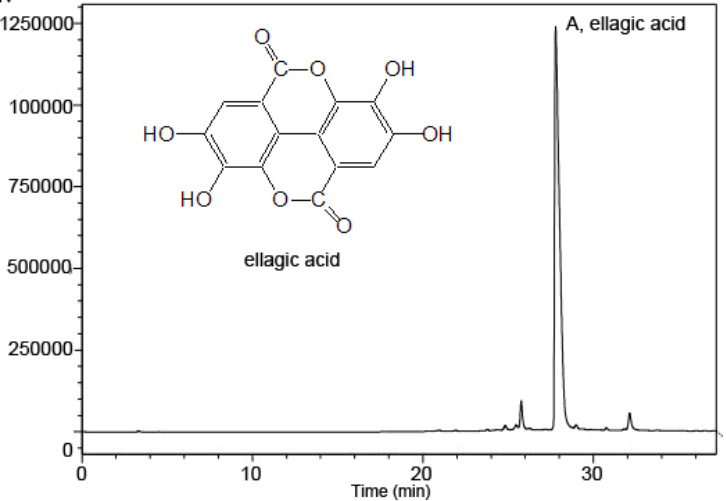
Figure 1. A typical HPLC chromatogram of a methanol extract of the infructescence of P. strobilacea , A, ellagic